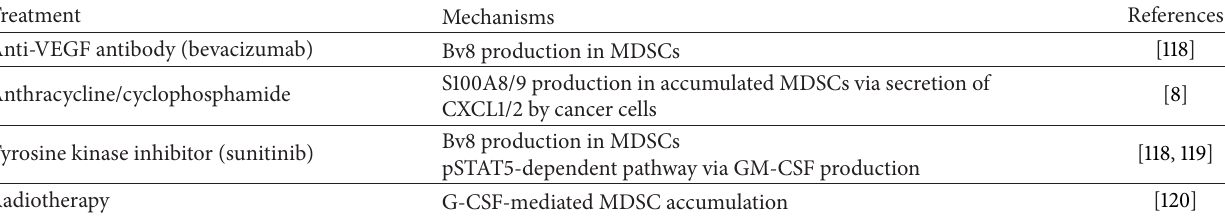
Table 1: MDSCs-mediated refractoriness to chemotherapy or